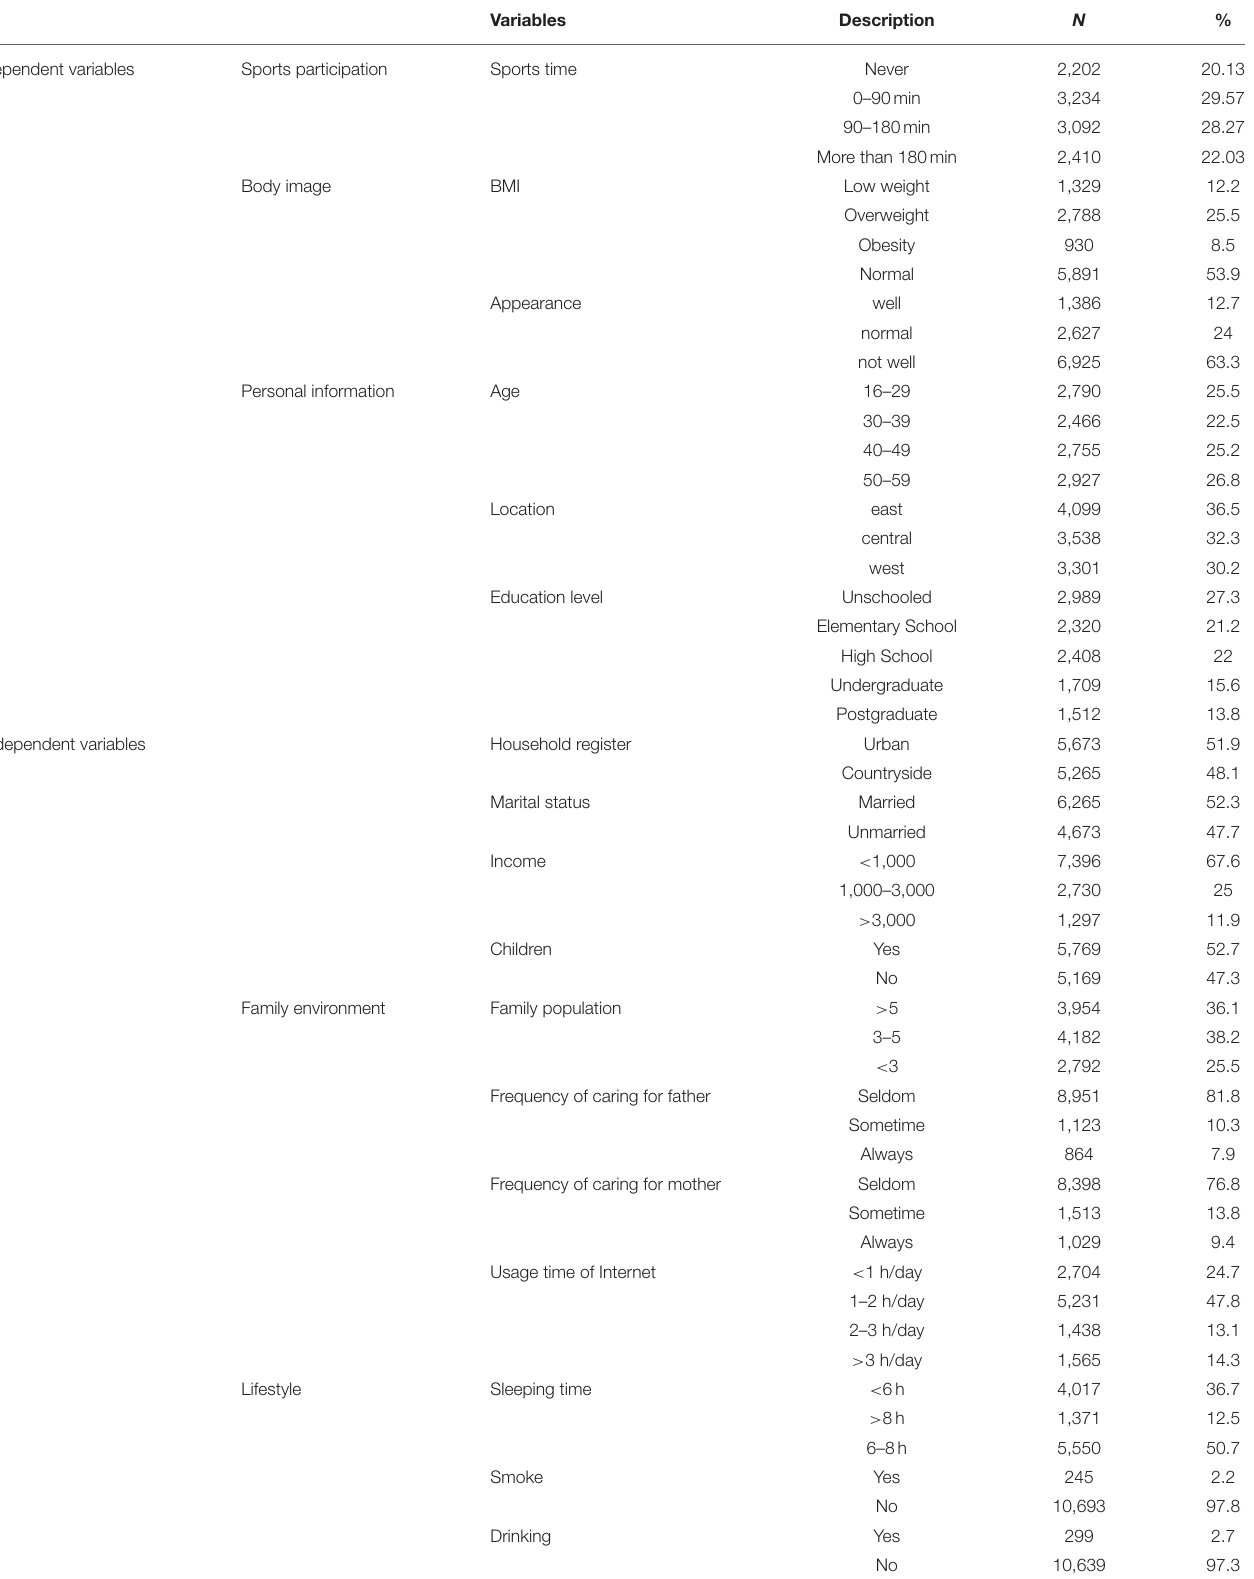
TABLE 1 | Variable description of female participants ( N =